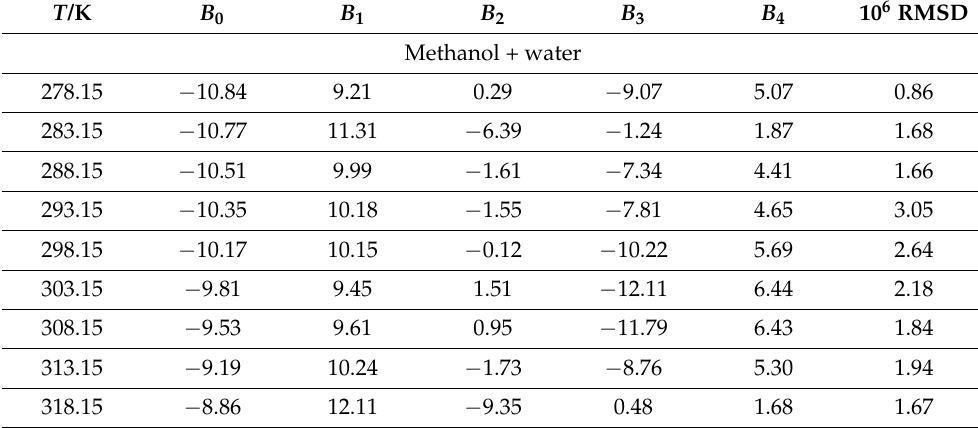
Table 6. Model parameters of CNIBS/R-K model for molar ratio solubility of florfenicol in binary